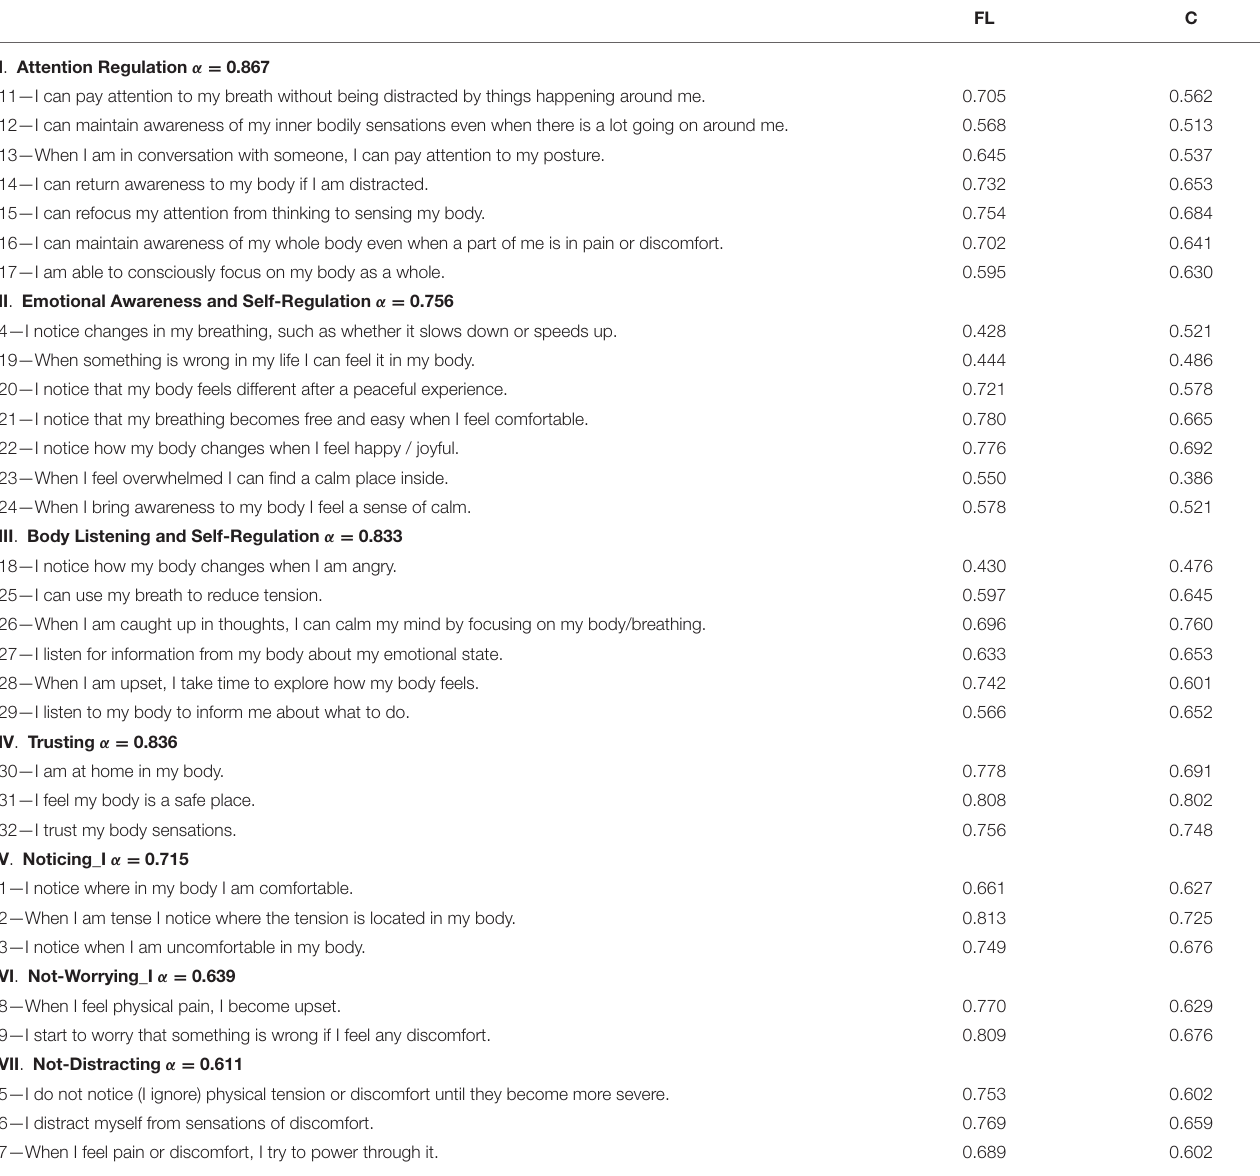
TABLE 9 | Exploratory PCA of the MAIA items in Indian participants.